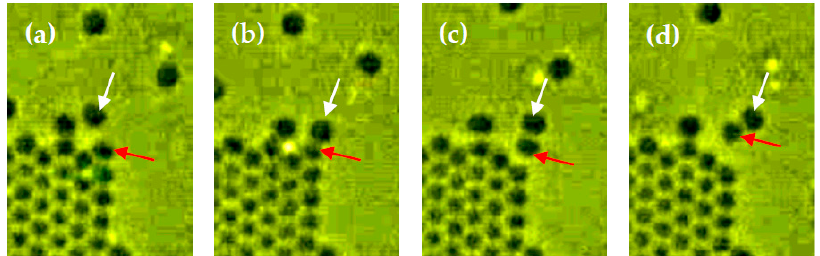
Figure 7. The time course of a “peeling off” process caused by the additional adsorption of a particle from bulk solution onto the other particle on a step. ( a ) A particle approaches a top layer; ( b ) The particle adsorbs to the edge particle of the layer; ( c ) The edge particle is desorbing from the layer with the adsorbed particle; ( d ) The particle pair is completely peeled off the top layer of particles.